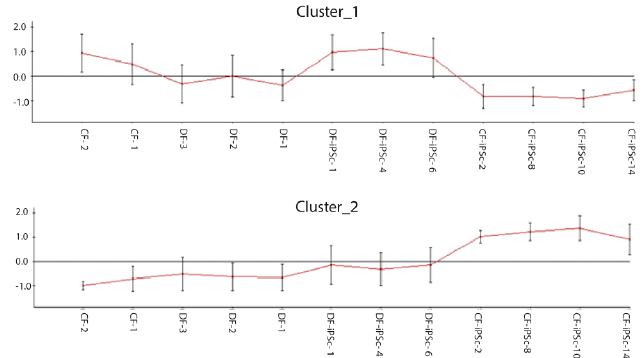
Figure 3. Microarray chip gene expression; 6367 differentially expressed probes selected by padj ≤ 0.05 and absolute log FC ≥ 0.75 were clustered to 11 clusters (data not shown); clustering of differentially expressed genes in CF-iPSCs versus DF-iPSCs. Cluster 1: Highly expressed in DF-iPSC vs CF-iPSC; cluster 2: Highly expressed in CF-iPSC vs DF-iPSC ( p ≤ 0.05 and absolute log FC ≥ 0.75).